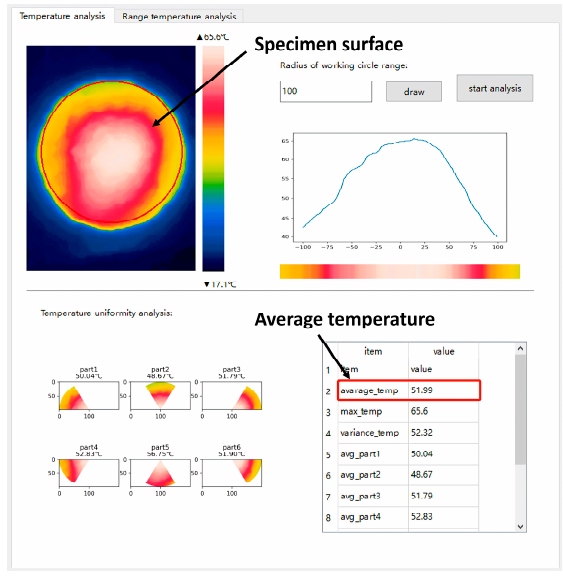
Figure 8. Surface temperature test of the specimens.